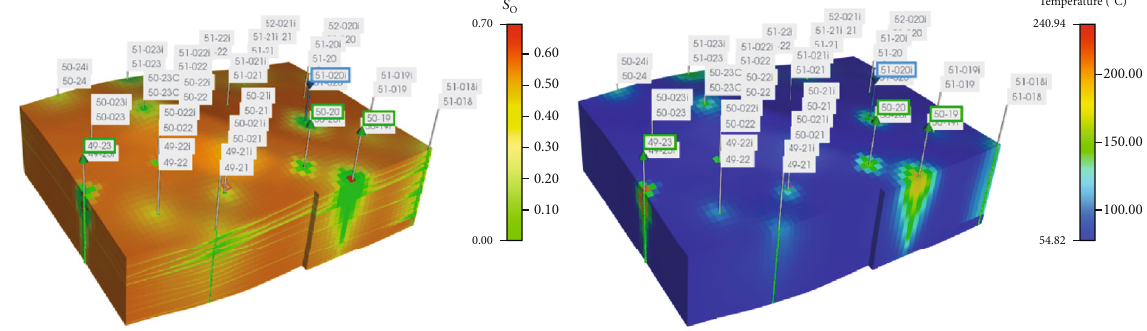
Figure 18: Post-CSS temperature and oil saturation distribution for the D block sector model (2018-10-30).